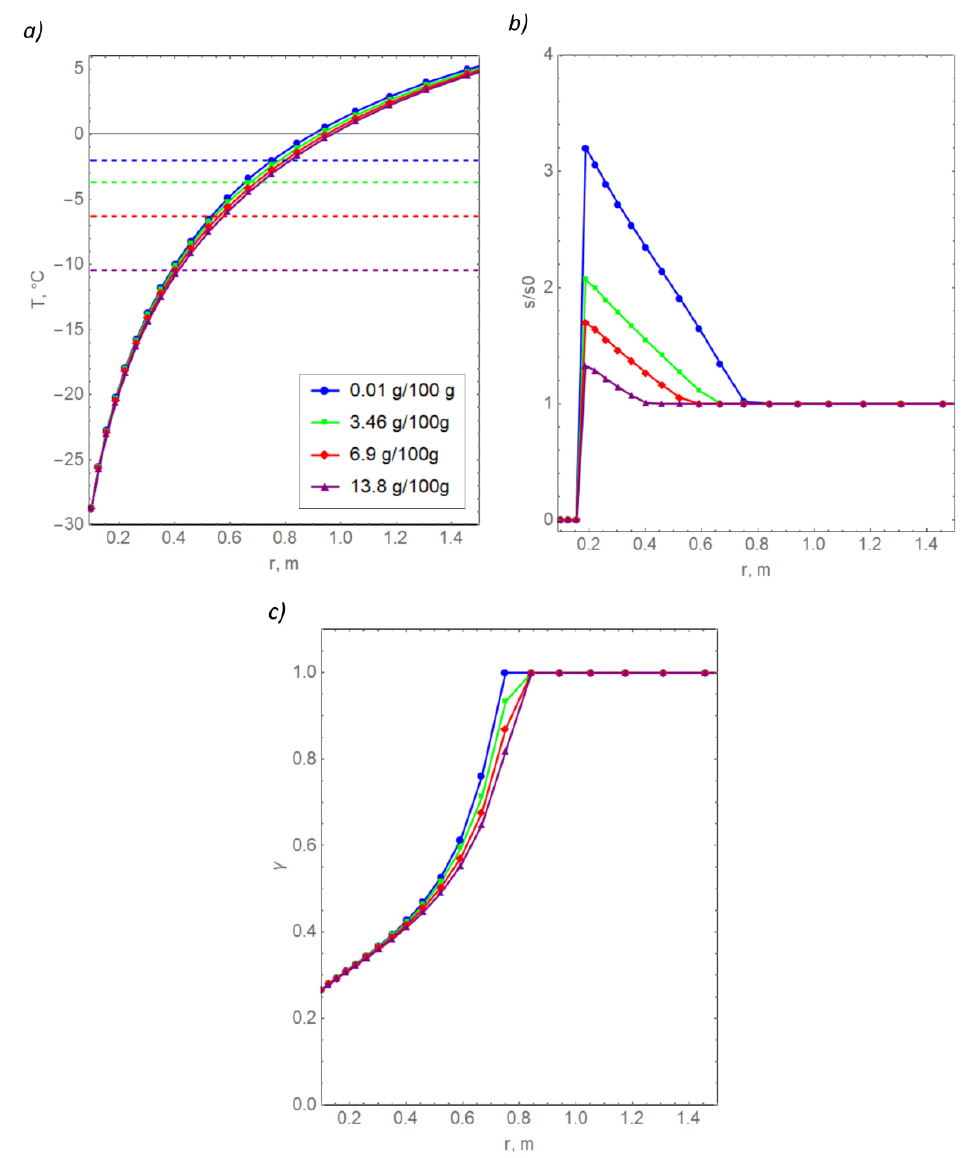
Figure 7. Radial distributions of temperature ( a ), salinity ( b ), and the volume fraction of unfrozen water ( c ) in clay for various values of initial salinity.